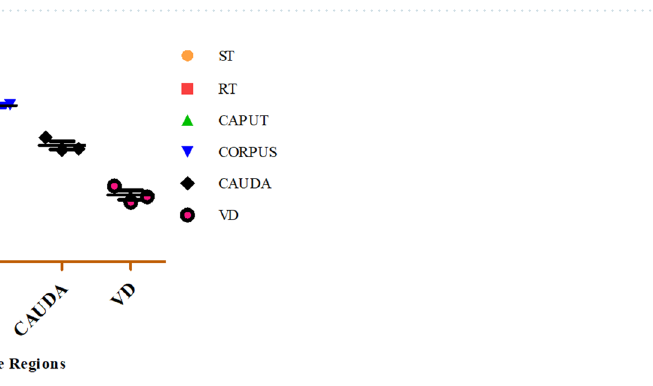
Figure 2. The BBD129 gene phylogenetic tree analysis was performed using the MEGA-X bioinformatics tool. The RLM-RACE amplified BBD129 mRNA has shown a strong evolutionary relationship within the Bovidae family members. The BBD129 amino acid sequence variations increase as the distance between mammalian species increases.